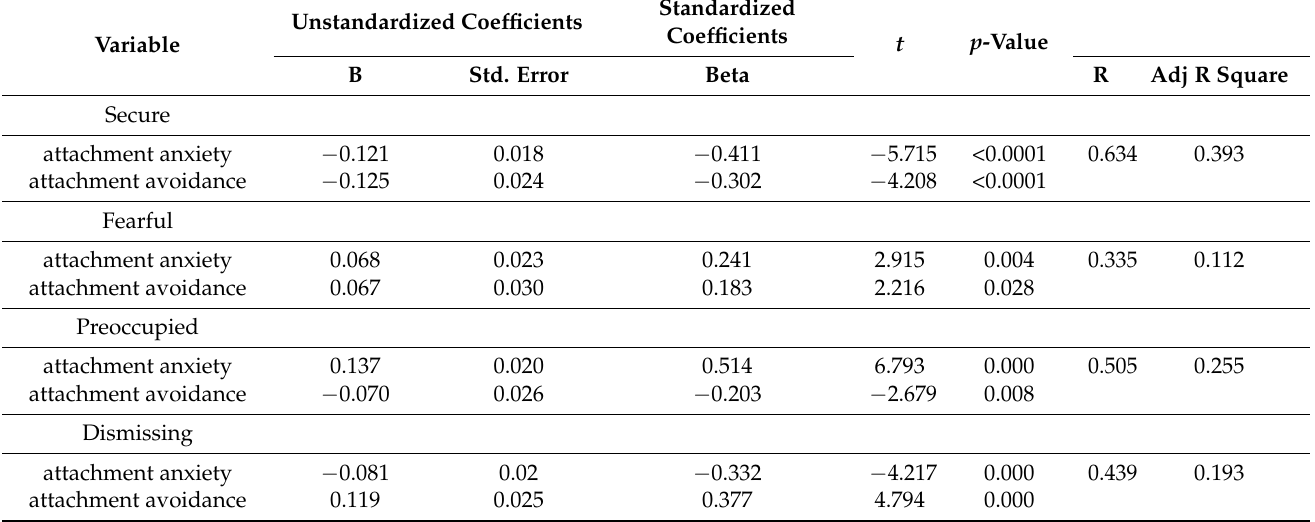
Table 5. Predicting coefficients of RQ styles (categorical) by means of the ECR-R when subjects with discrepancies in RQ were removed.